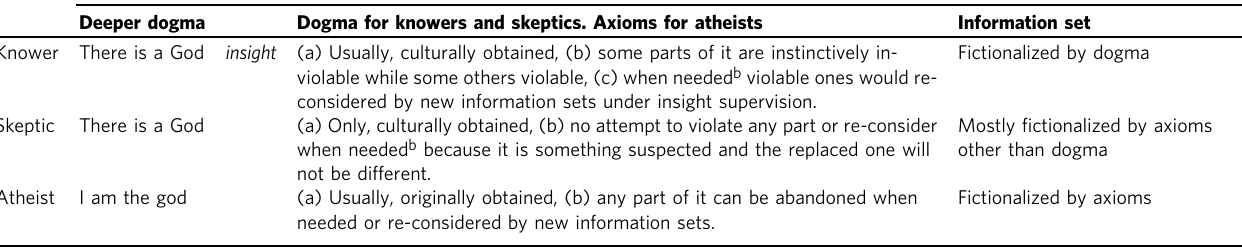
Table 1 Parts of the Dogmatic